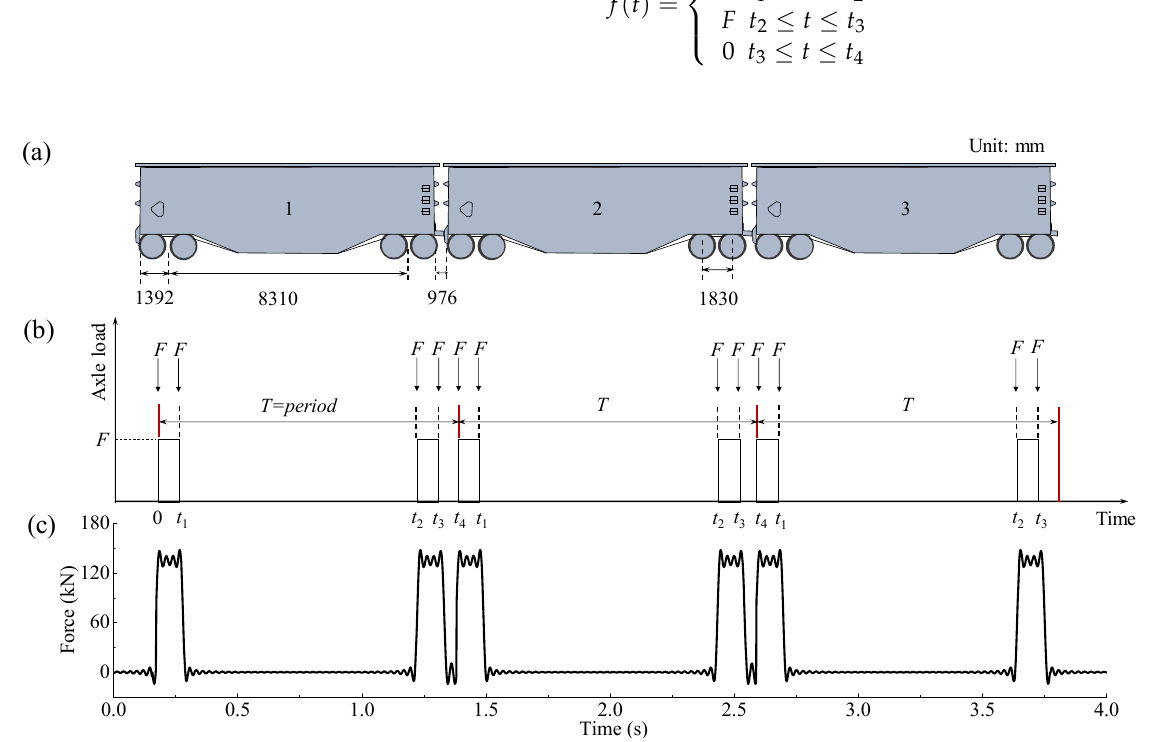
Figure 6. Schematic of ( a ) train wagons, ( b ) normal force variation of wagon wheels, and ( c ) dynamic load of a train with an axle load of 275 kN and speed of 60 km/h.